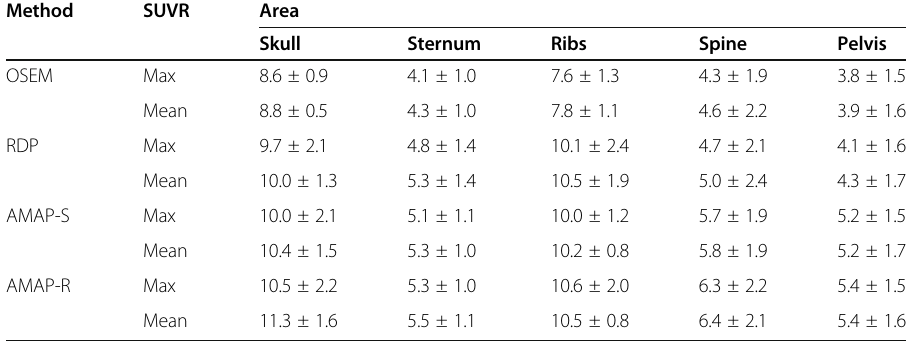
Table 7 SUVR max and SUVR mean (SUVR = SUV lesion /SUV normal uptake ) (mean ± standard deviation) for